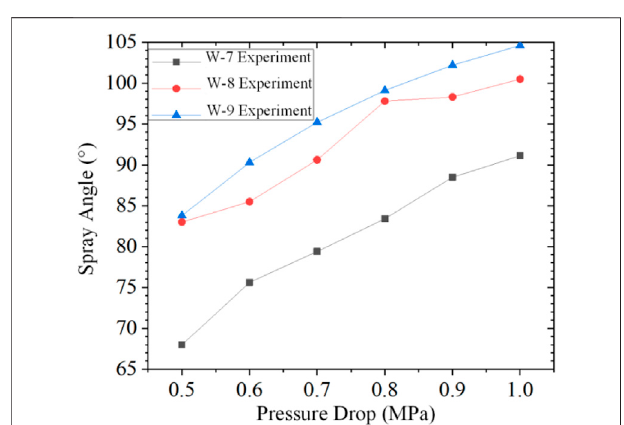
FIGURE 9 | Impacts of recess length on the spray angle under different pressure